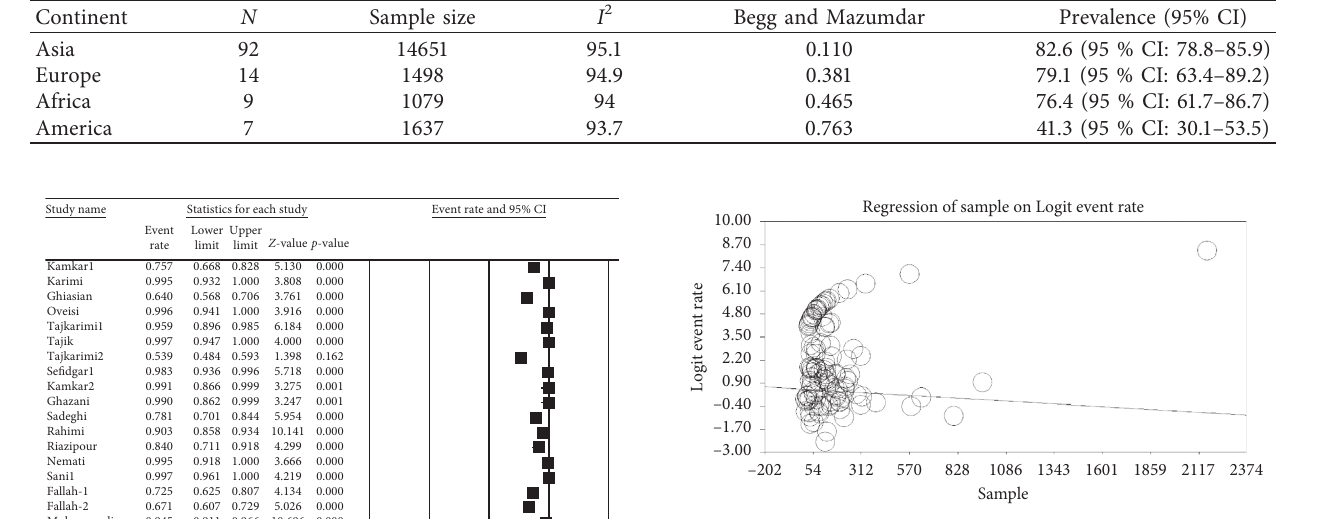
Figure 5: Metaregression of the relationship between sample size and prevalence of aflatoxin M1 in milk.